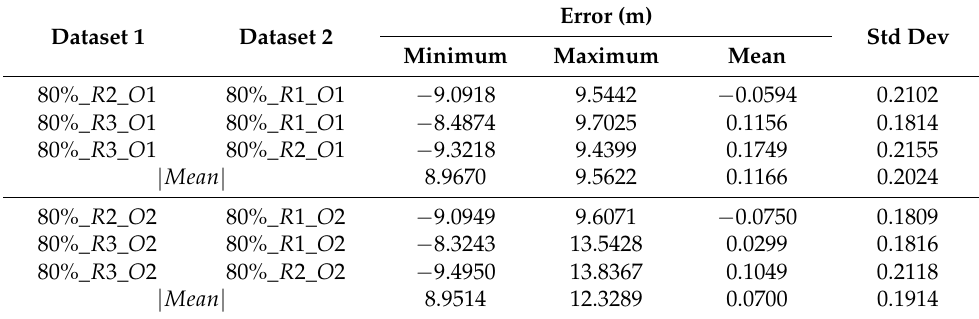
Figure 6. The elevation error correlation results of different datasets under repeated observations, Corr is the correlation coefficient, ( a ) represents the orthophoto datasets, ( b ) represents the oblique imaging datasets. Table 6. Statistics of DoD internal precision results of different datasets under repeated